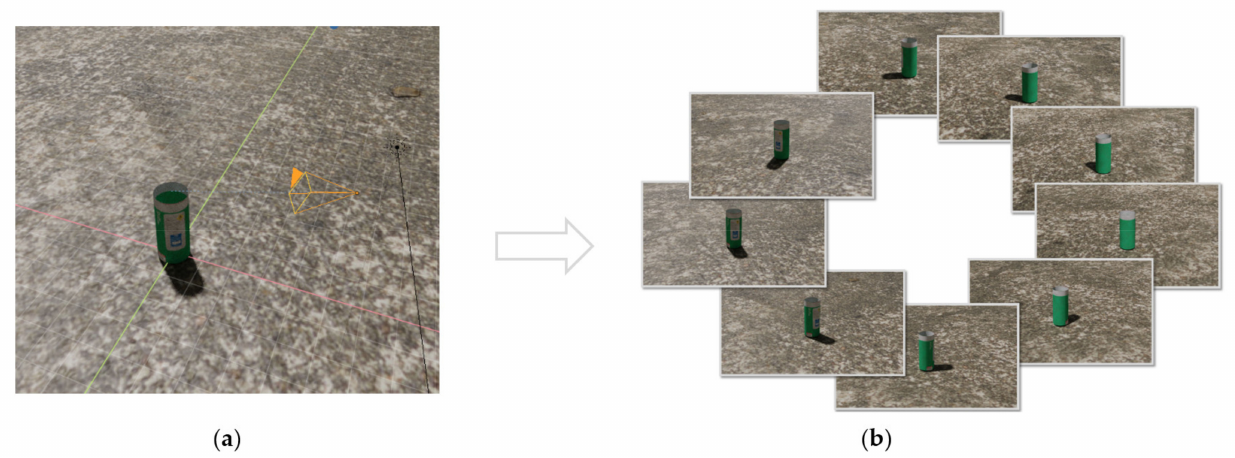
Figure 2. ( a ) Scene setting; ( b ) rendered multi-view 2D